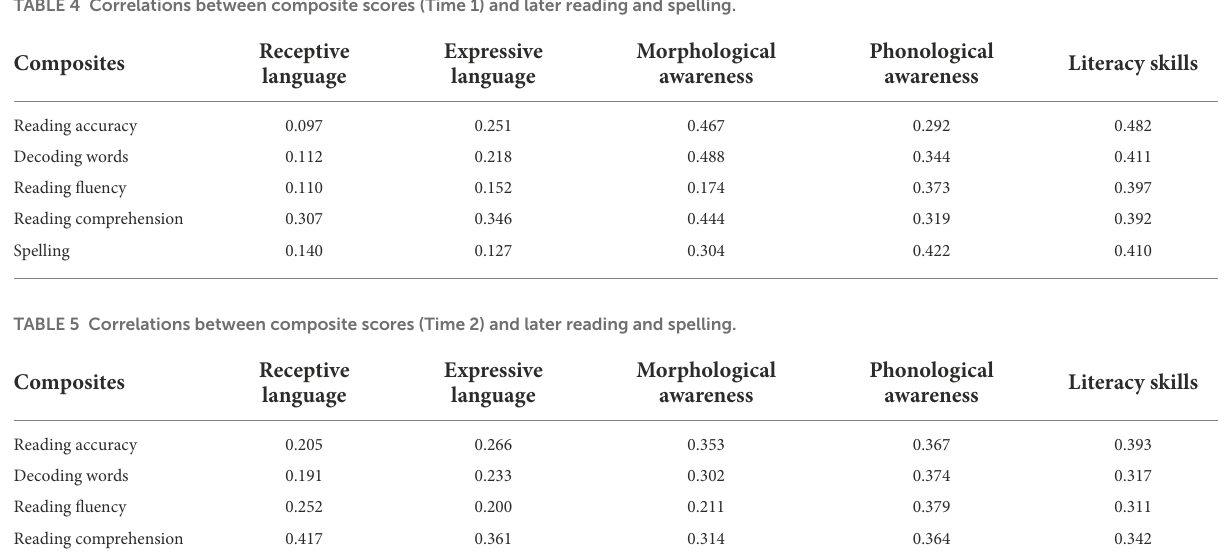
TABLE 4 Correlations between composite scores (Time 1) and later reading and spelling.